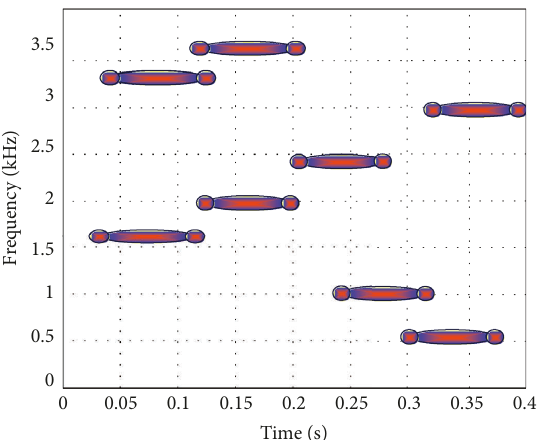
Figure 7: Spectrogram time-frequency analysis